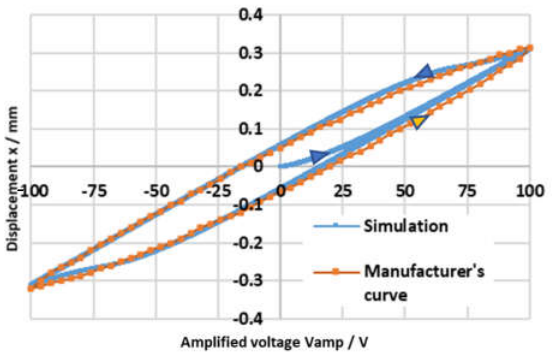
Figure 4. Hysteresis curve provided by the manufacturer compared with the hysteresis curve obtained with the simulations (model NAC2643).